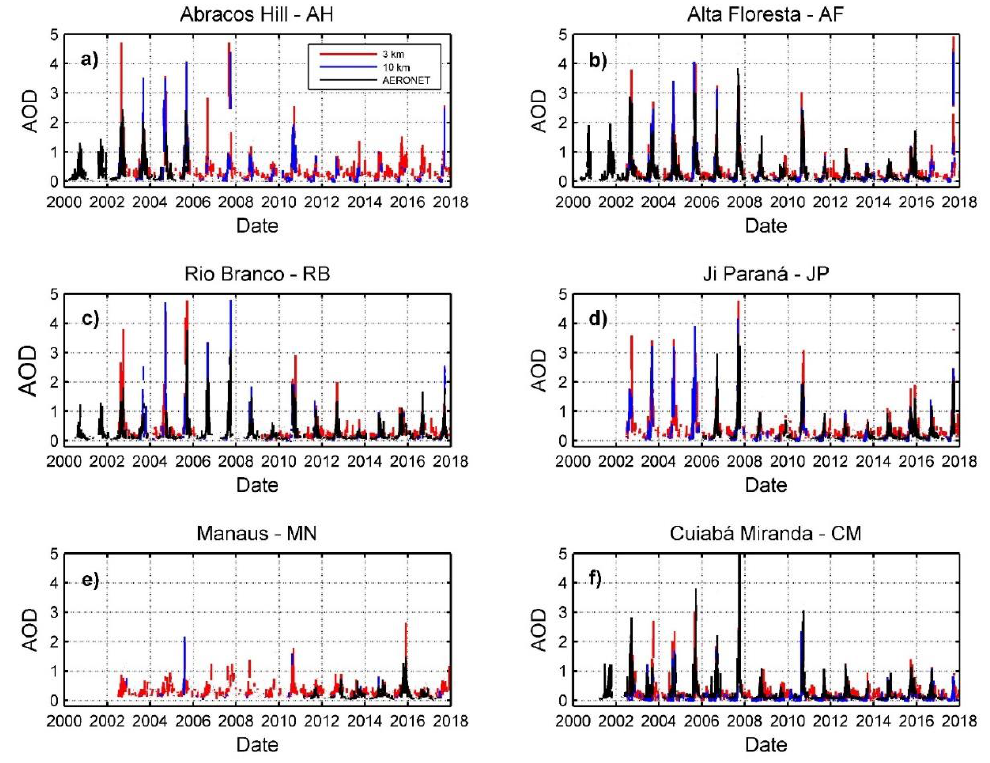
Figure 2. Time series AOD AERONET AOD and MODIS DT 3 km and 10 km for the analyzed sites: ( a ) Abracos Hill, ( b ) Alta Floresta, ( c ) Rio Branco, ( d ) Ji Paran á , ( e ) Manaus, and ( f ) Cuiab á